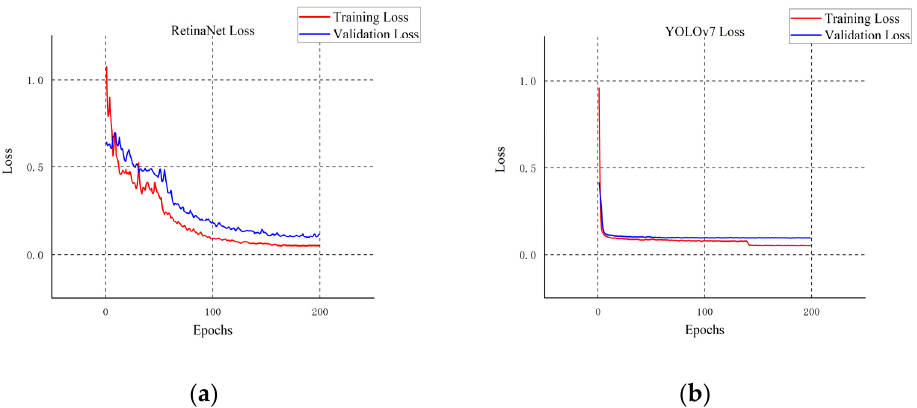
Figure 10. ( a ) The loss changes of the RetinaNet model; ( b )The loss changes of the YOLOv7 model.